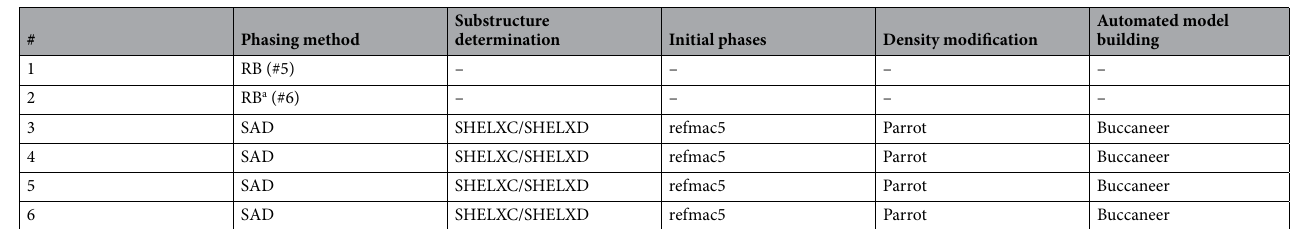
Table 8. Phasing procedure for p62 PH datasets. a Rigid body refinement using Refmac5. Numbers in parentheses indicate the starting model used for